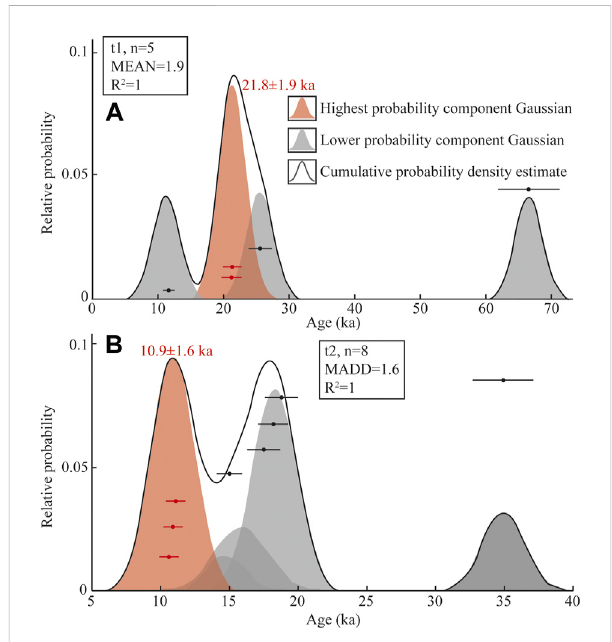
FIGURE 3 Gaussian separation curves for all 10 Be exposure ages for moraines (A) t1 and (B)